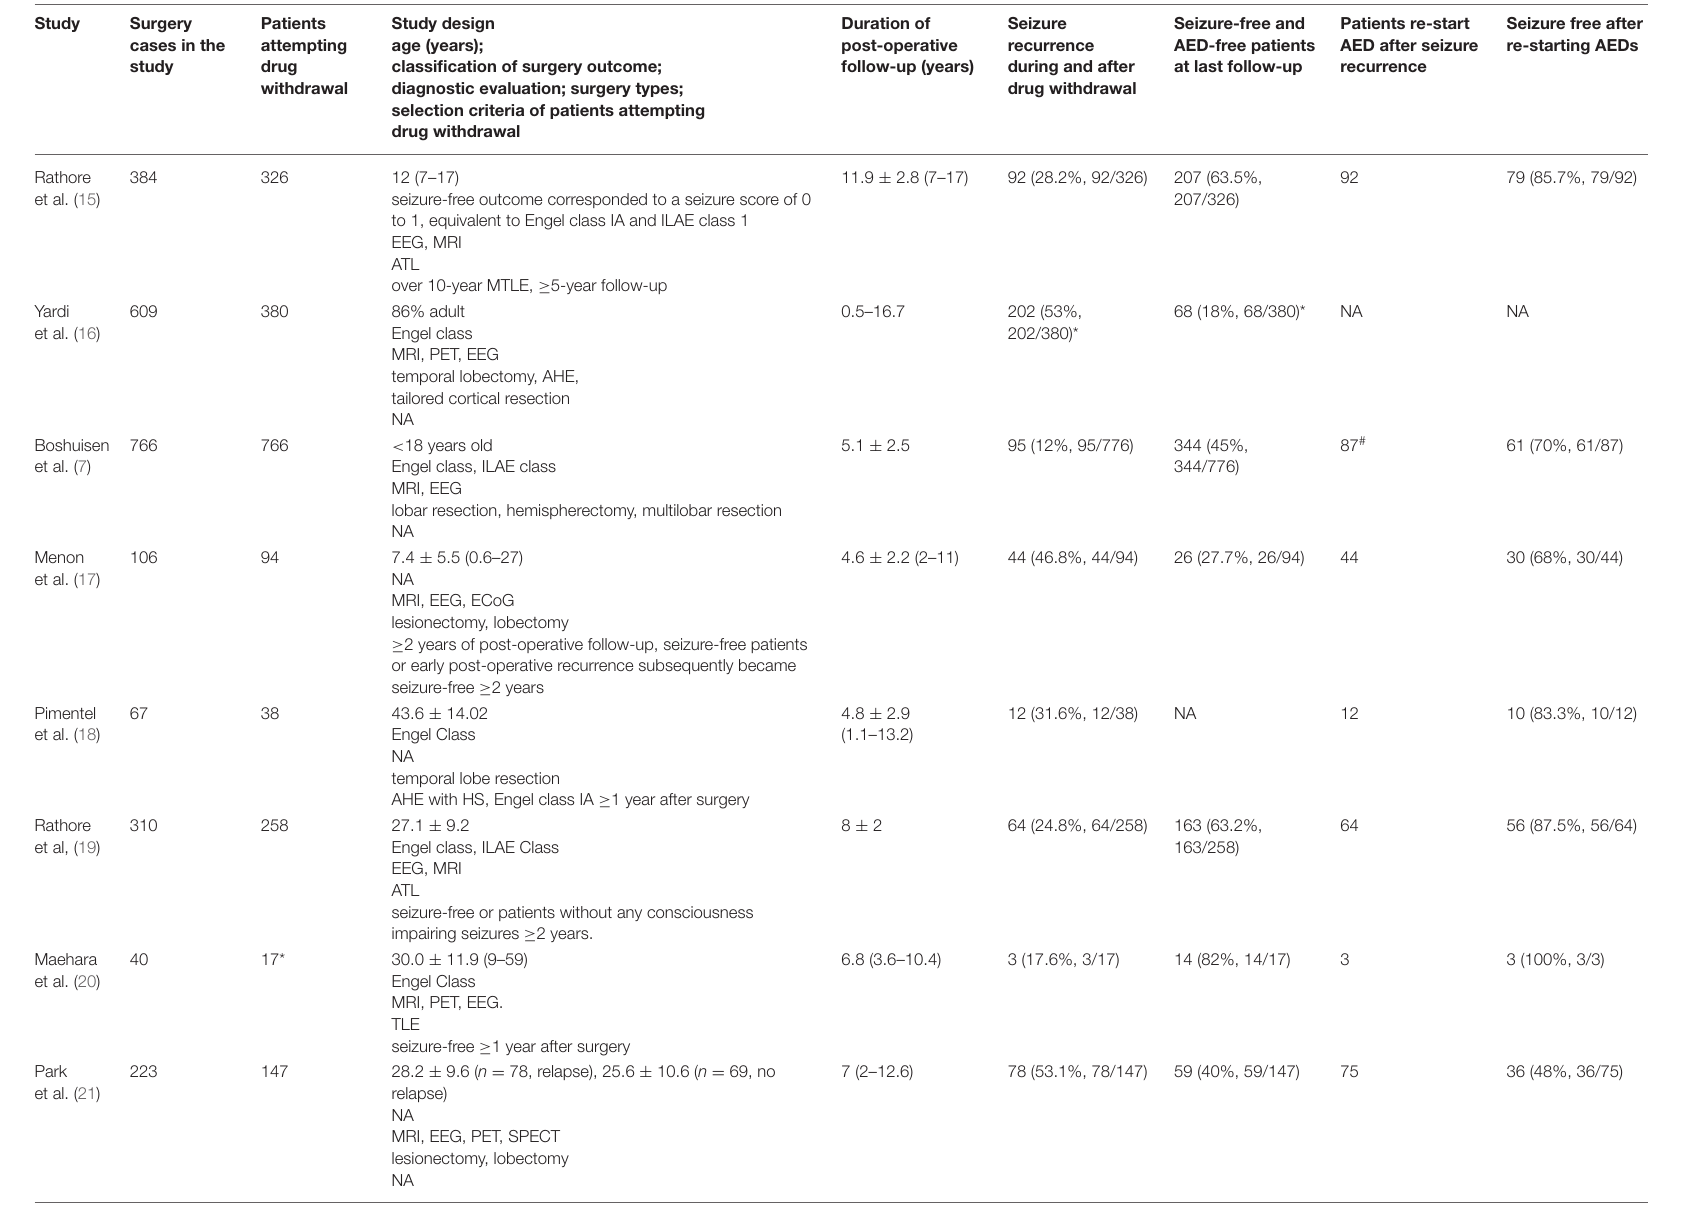
TABLE 1 | Outcome of drug withdrawal after successful epilepsy